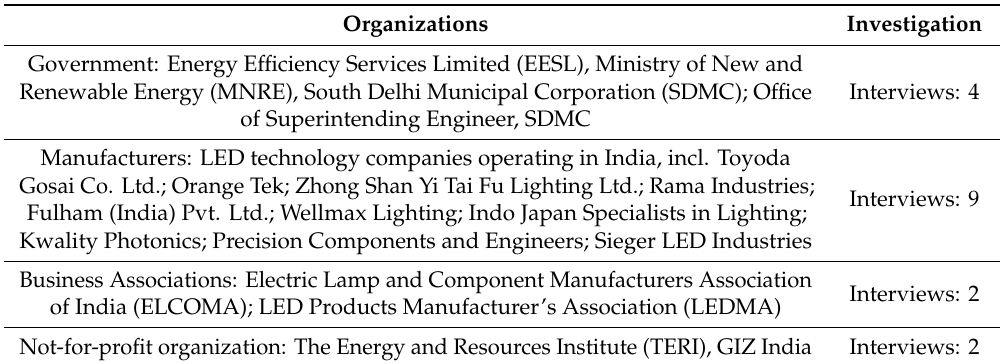
Table 2. List of expert